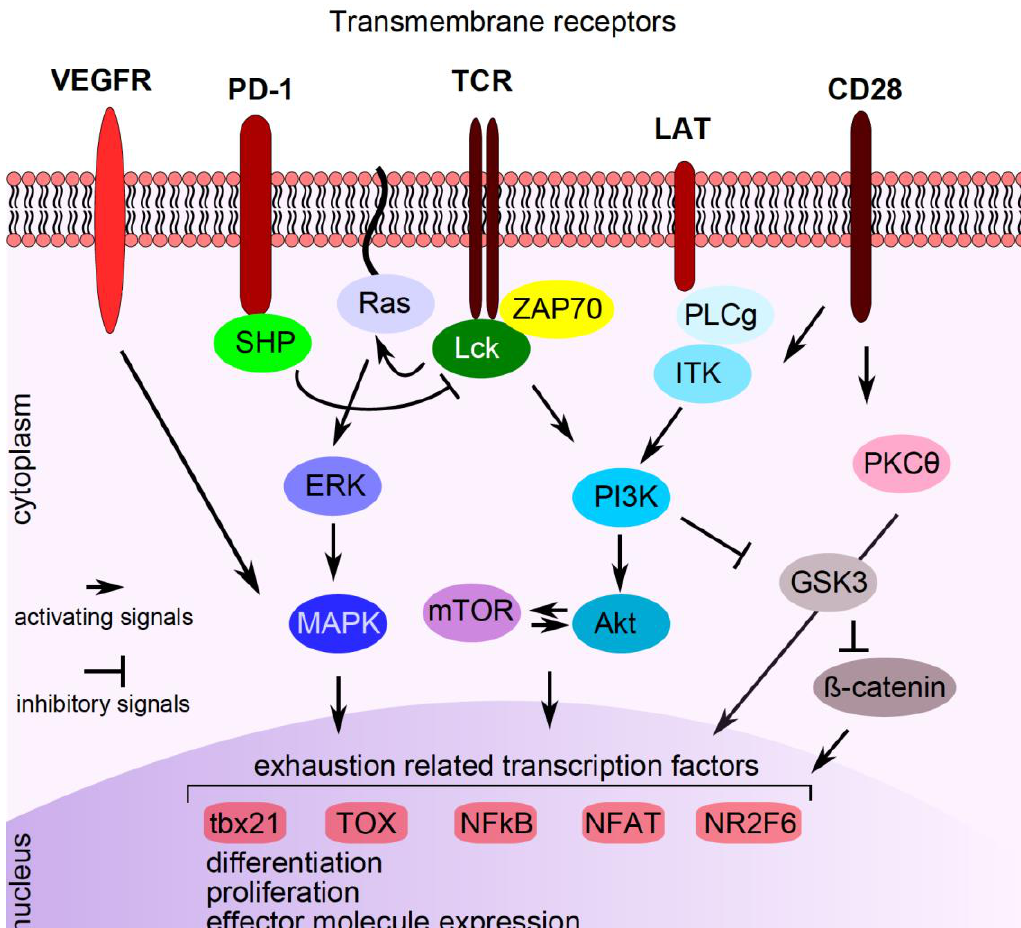
Figure 2. Pathways interfering with PD-1 signaling. Signaling compounds are indicated in the cytoplasm, transcription factors/repressors are indicated in the nucleus. See text for explanations. VEGFR: vascular endothelial growth factor receptor, PD-1: programmed cell death protein 1, TCR: T cell receptor, LAT: linker for activation of T cells, CD: cluster of di ff erentiation, SHP: small heterodimer partner, Lck: lymphocyte-specific protein tyrosine kinase, ZAP70: zeta chain-associated protein kinase 70, PLCg: phospholipase C gamma 1, ITK: interleukin-2 inducible T cell kinase, ERK: extracellular signal-regulated kinase, PI3K: phosphatidylinositol 3-kinase, PKC Ө : protein